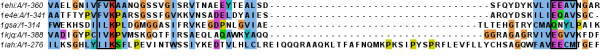
Alignment of the sequences using structural constraints.